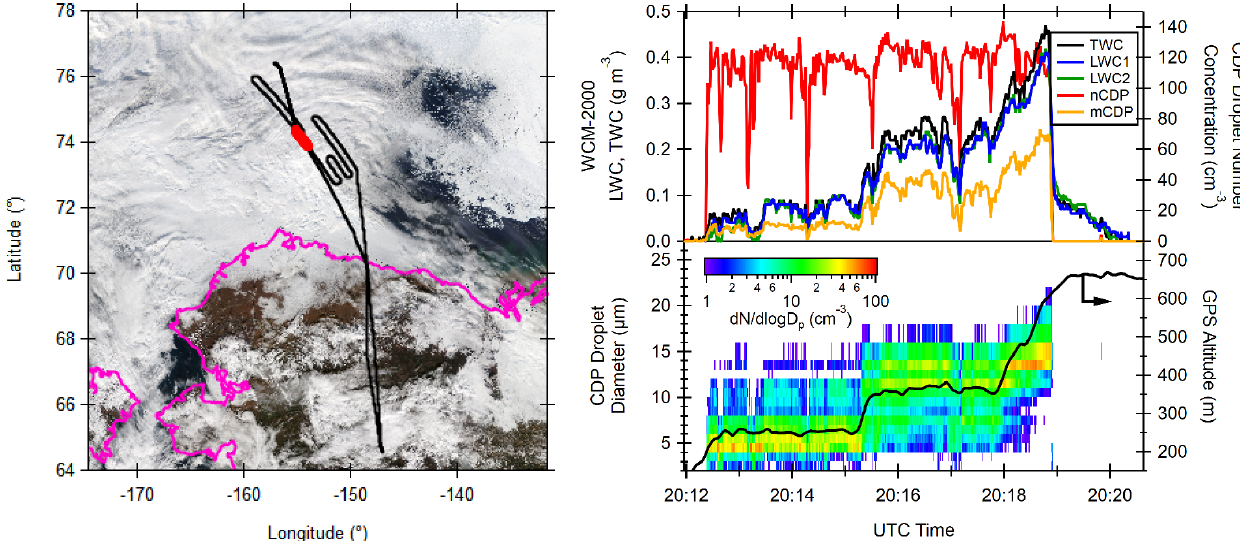
Figure 1. Example map (left) and time series (right) of profile sampling of low-level clouds during ARISE. The black trace in the map indicates the C-130 flight track from Eielson AFB north to the Beaufort Sea, while the red shading denotes the portion of the flight shown in the time series. The time series data include CDP measurements of droplet number size distribution (d N / dlog D p ), and integrated number concentration (nCDP), integrated mass concentration (mCDP; calculated assuming a density of 1gcm − 3 ). Corresponding total water content (TWC) and liquid water content (LWC1, LWC2) mass concentrations measured by the WCM-2000 are also shown. The black trace in the lower right panel is the aircraft GPS